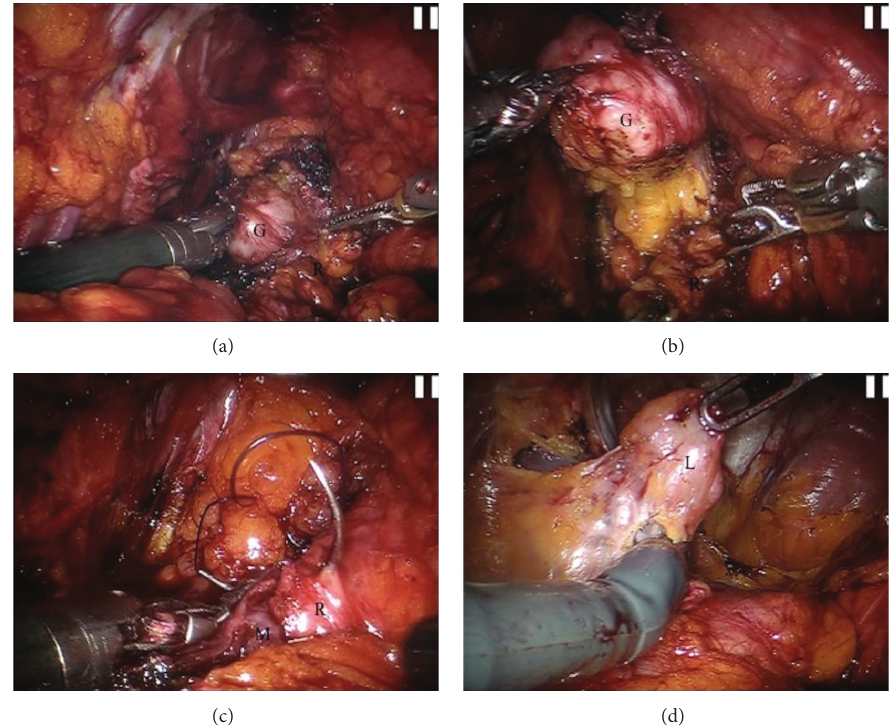
Figure 2: (a) The tumor is identified at the left lateral wall of the rectum. (b) The GIST is dissected free under direct vision with safe margins. (c) Suturing the rectal wall in a two-layer fashion with the mucosa of the rectum intact. (d) Resection of suspicious pelvic lymph nodes. G: GIST, R: rectum, M: mucosa of the rectum, and L: pelvis lymph